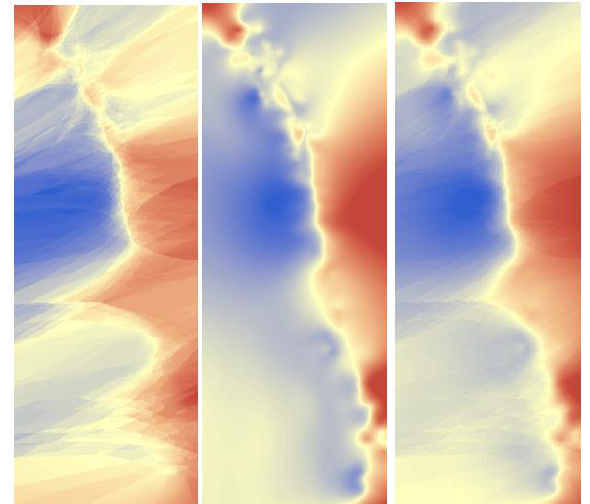
Figure 18. From left: Kriging, Topoggraphic and merging both interpolation techniques with ratio 50% each.